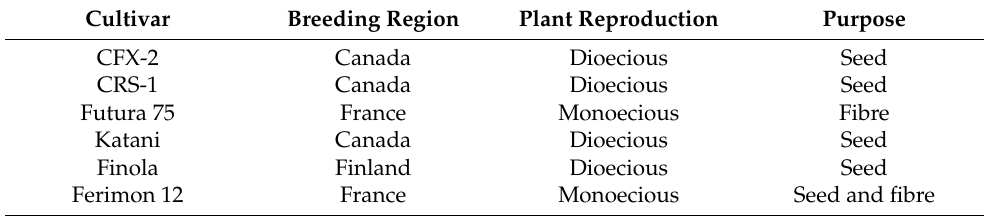
Table 1. Description of the cultivars in which volatile emissions were investigated. Cultivar Breeding Region Plant Reproduction Purpose CFX-2 Canada Dioecious Seed CRS-1 Canada Dioecious Seed Futura 75 France Monoecious Fibre Katani Canada Dioecious Seed Finola Finland Dioecious Seed Ferimon 12 France Monoecious Seed and